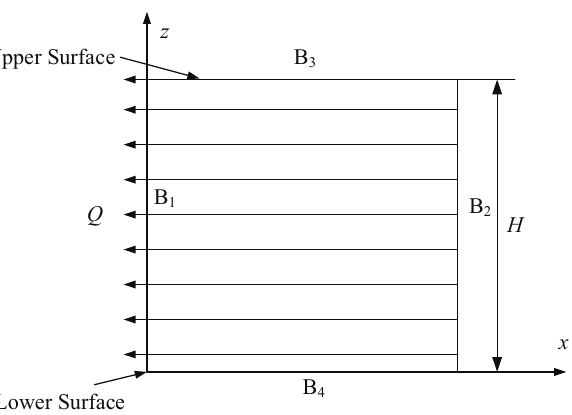
Figure 1: Functionally graded plate discrete